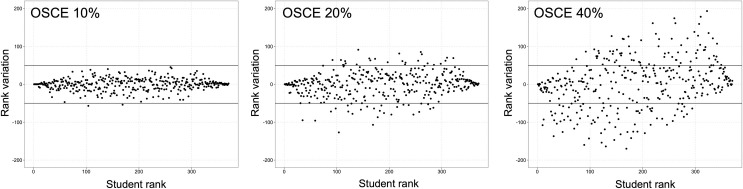
Variation in ranking based on the mean fourth-year multiple-choice question (MCQ)-based grades, with incremental percentages of OSCE grade integrated into the final grade.The upper and lower solid black lines represent thresholds for +50 or -50 rank variation, respectively. Results are displayed for integration of OSCE grade with a 10%, 20% and 40% coefficient.